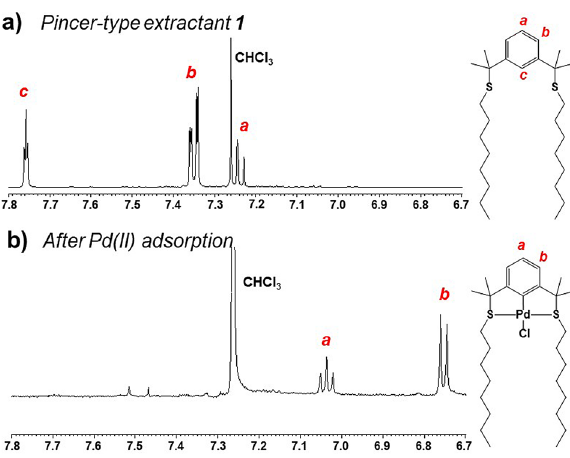
Figure 5. Partial 1 H NMR spectra of ( a ) pincer-type extractant 1 and ( b ) the Pd(II)–extractant 1 complex flaked from Pd(II)-loaded 1 -EIR (500 MHz, CDCl 3 , δ from